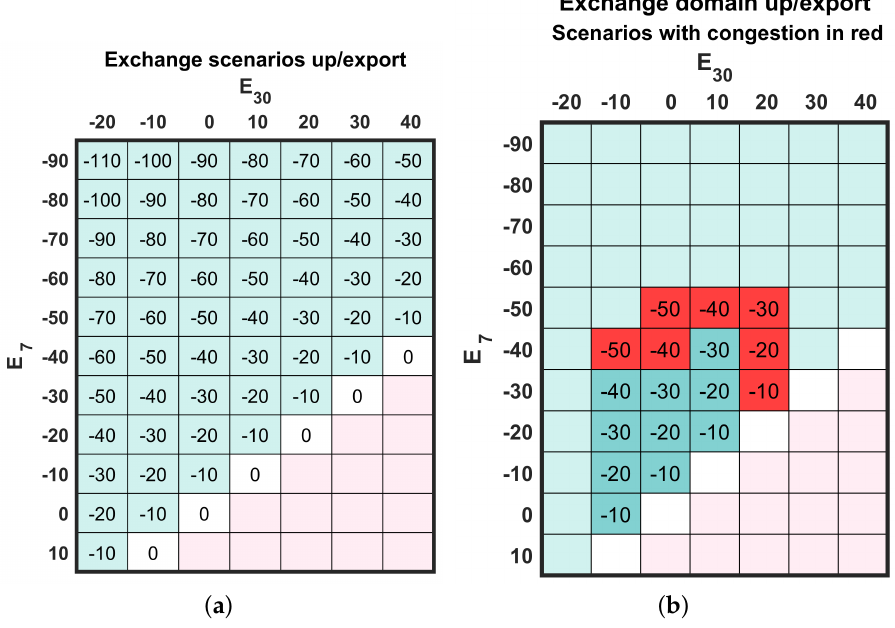
Figure 3. Net balancing activation volumes in the considered exchange scenarios: ( a ) All exchange scenarios; ( b ) Feasible scenarios.